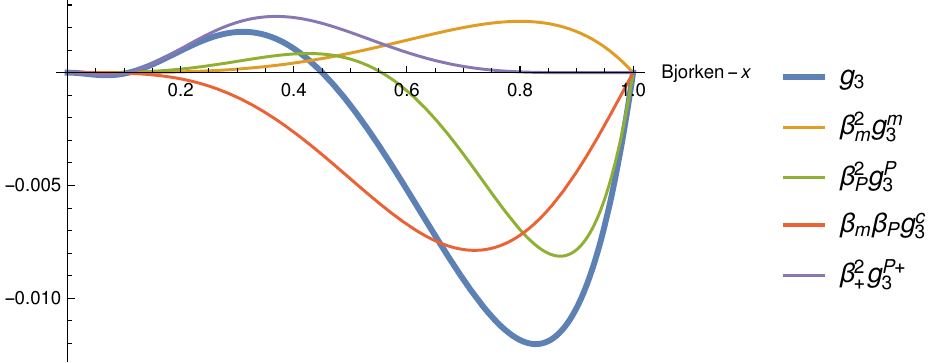
(6) . The meaning of k =0 O